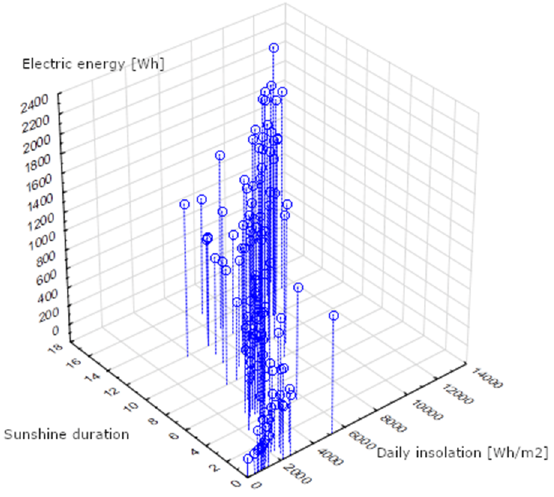
Figure 5. Impact of sunshine duration and insolation on the value of electricity from photovoltaic